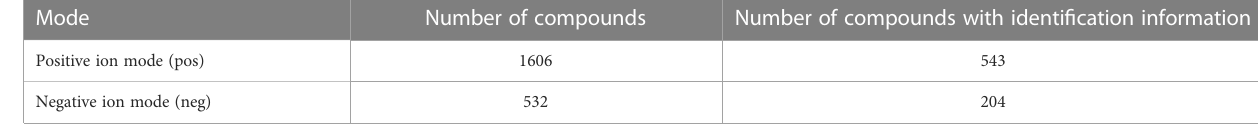
Positive ion mode (pos): when the substances are ionized in an ion source, the adduct ions are positive ions, such as H + , NH + 4 , Na + , K + . Negative ion mode (neg): when the substances are ionized in an ion source, the adduct ions are negative ions, such as -H,